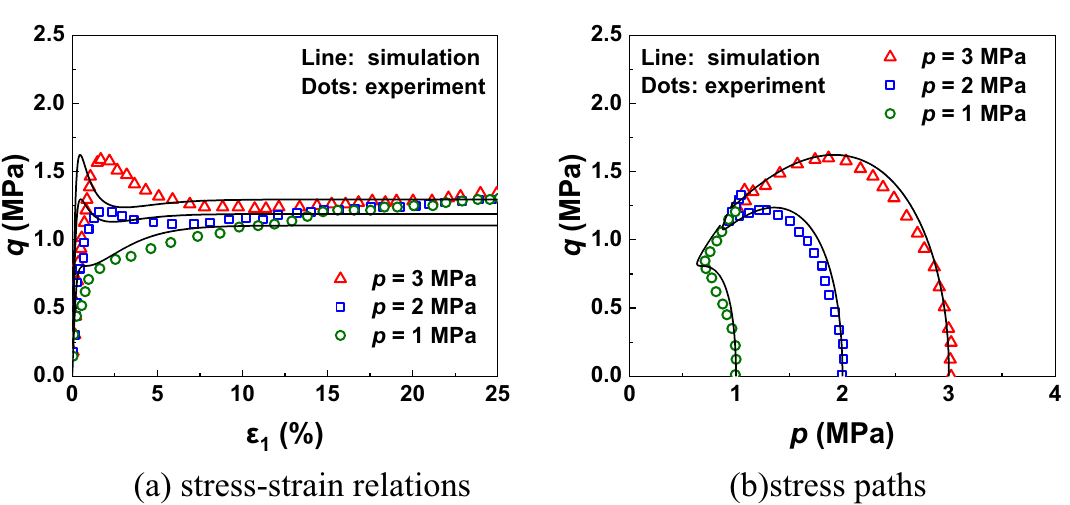
Figure 8. Model predictions and experiment results of Toyoura sand under undrained